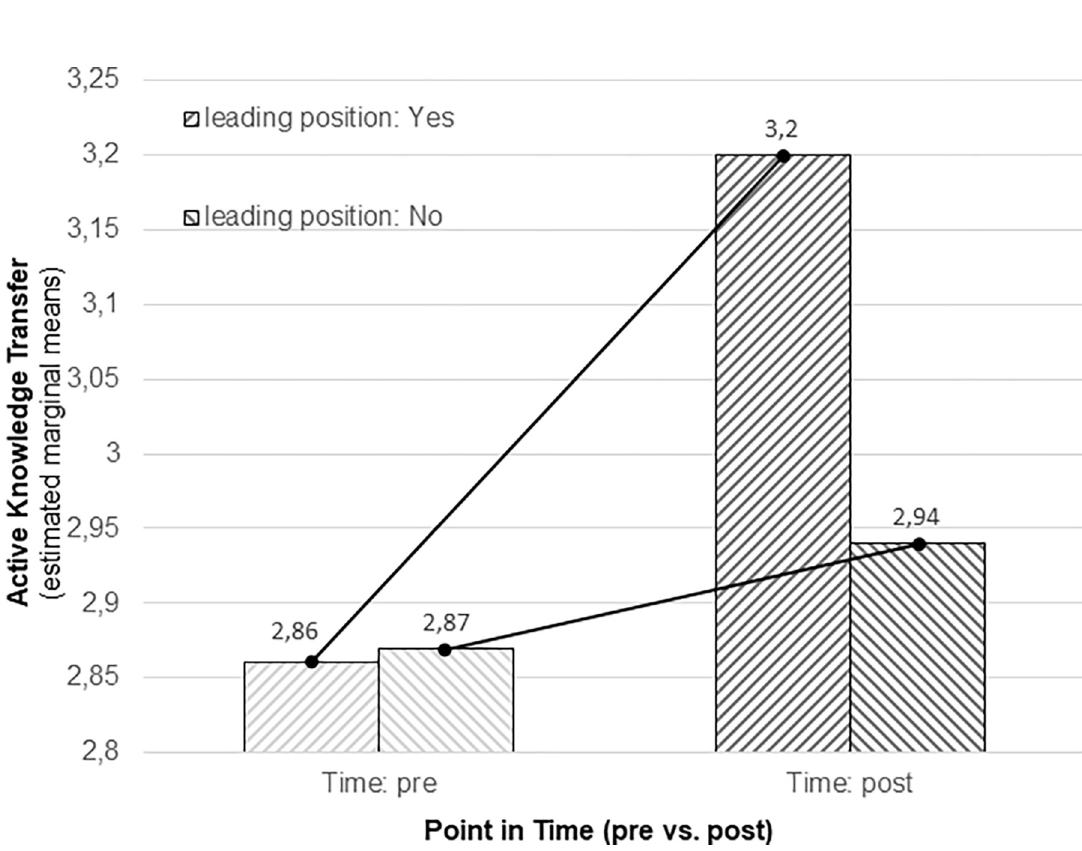
Fig 3. Active knowledge transfer as a function of point in time (pre vs. post) and management position (leading vs. non leading).